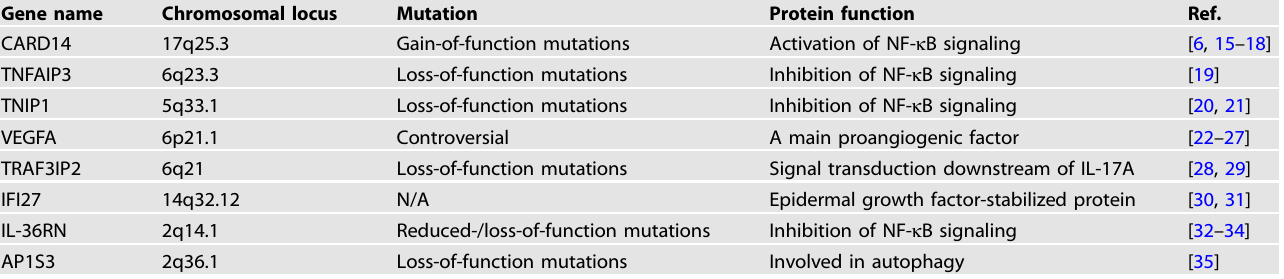
Table 1. Characteristics of mutations of gene associated with keratinocytes in